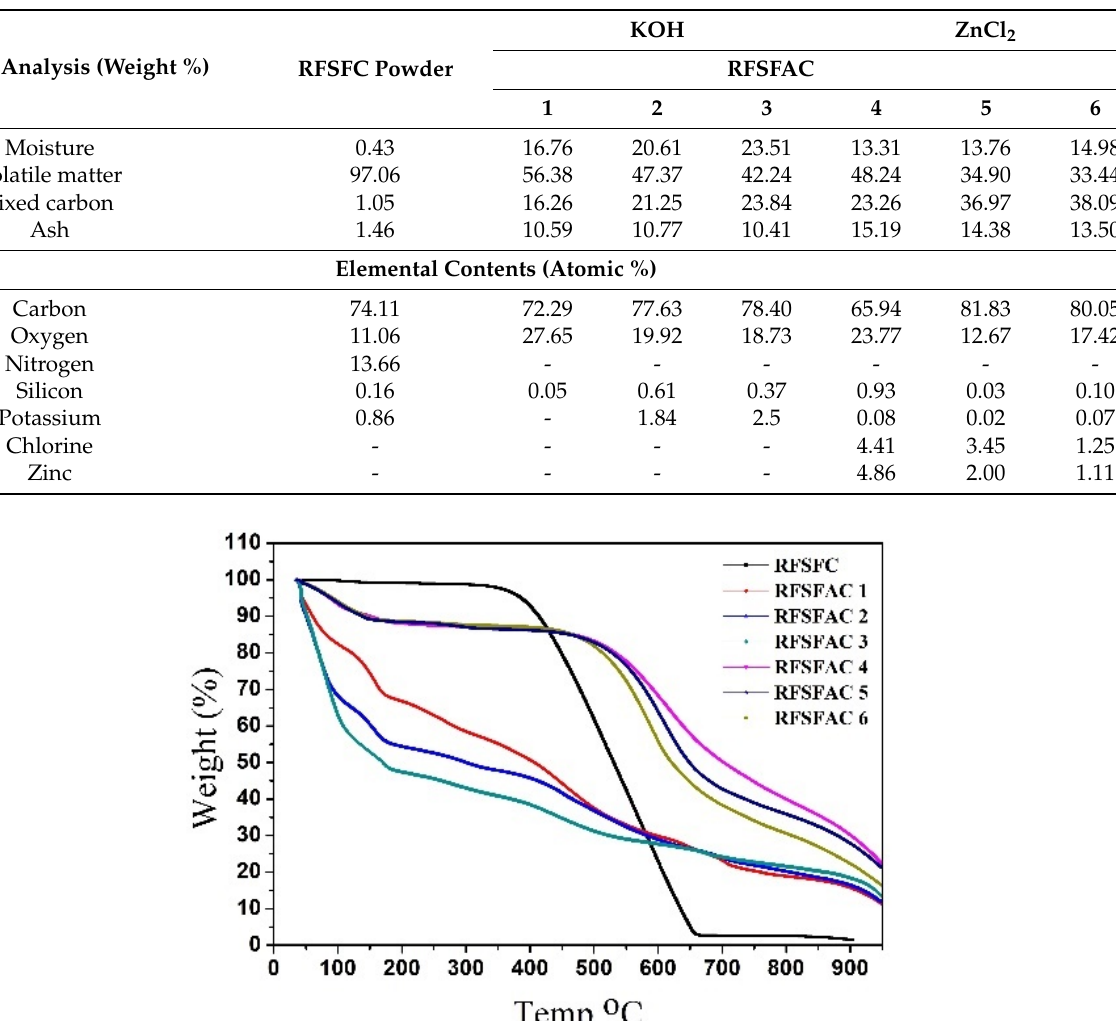
Table 2. Proximate analysis results and elemental contents before and after the activation process with different activating agents and impregnation ratios.